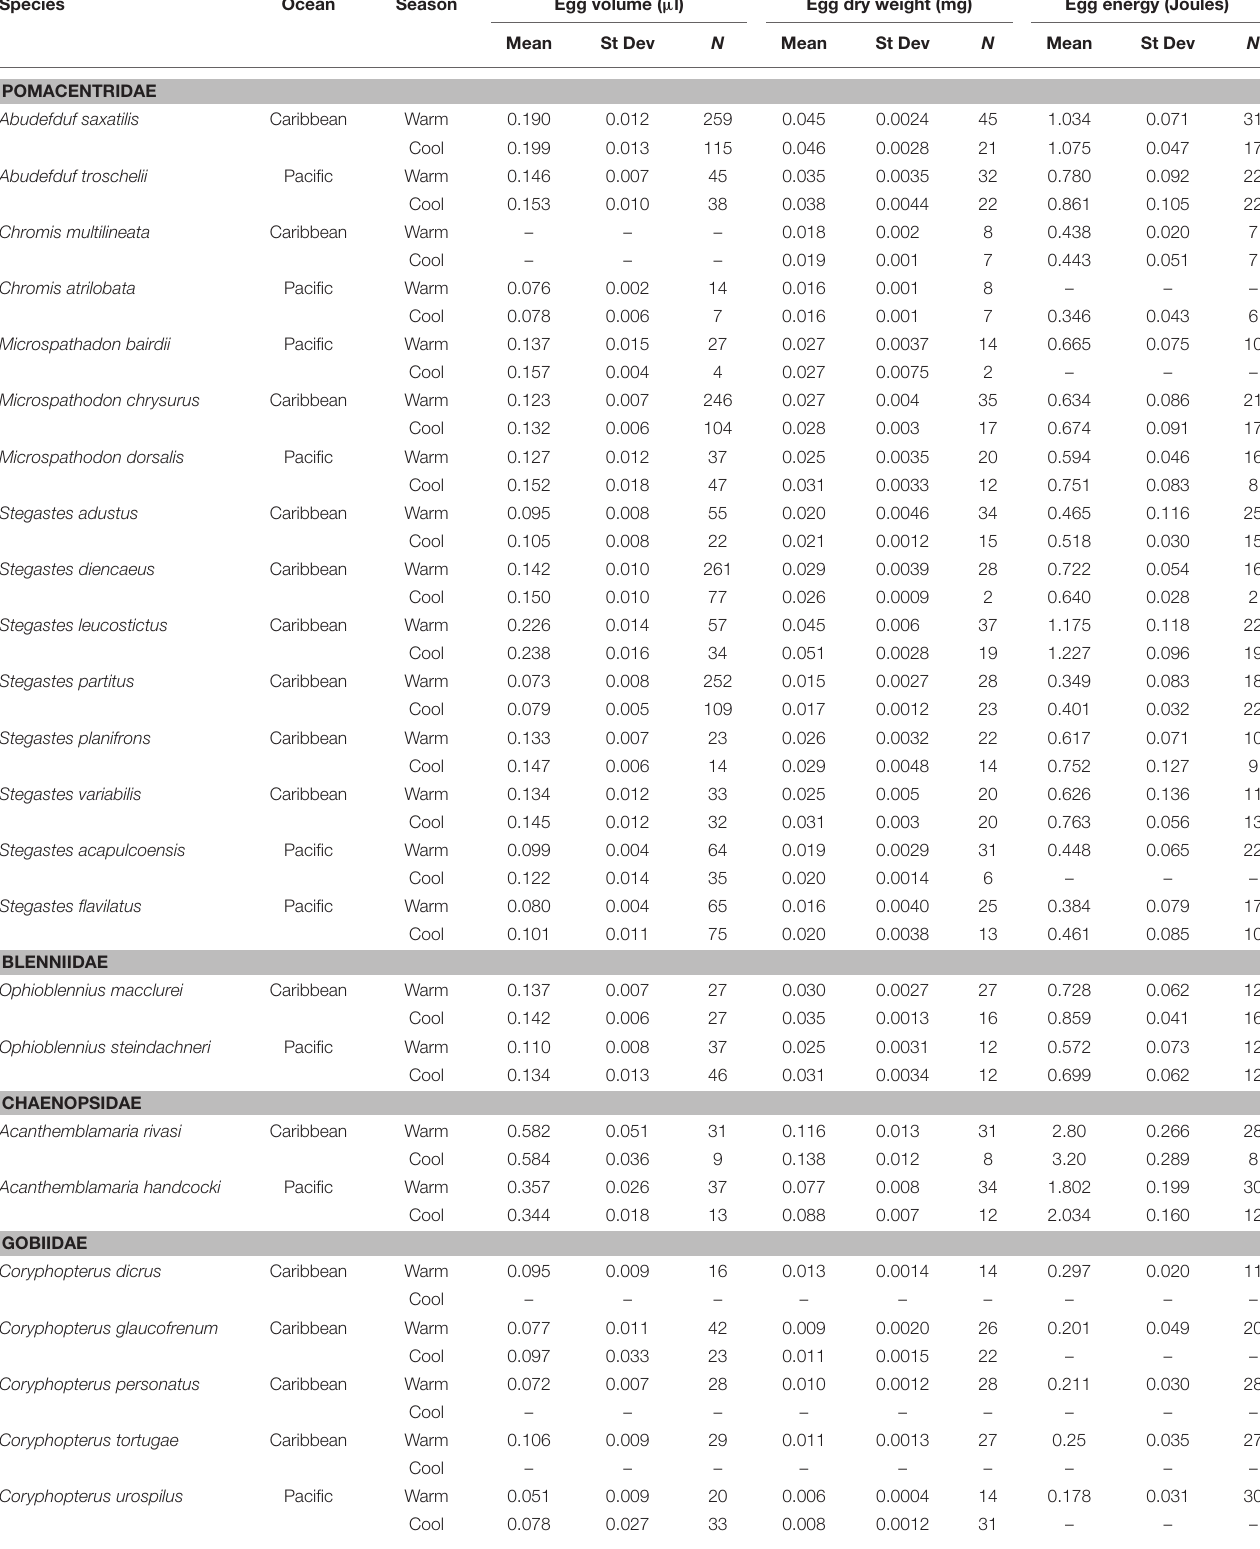
Supplementary Table 1 | Summary of egg volume, dry weight, and energy content of eggs of 24 neotropical reef fishes averaged for the cool and the warm seasons.